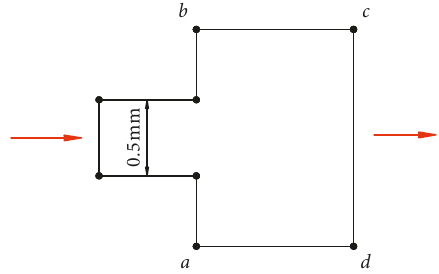
Figure 4: Structure of channel with sudden